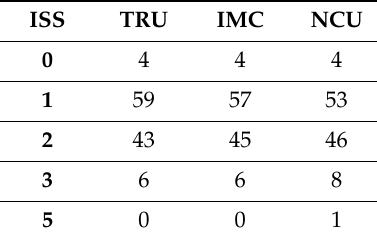
Table 5. Frequencies of all observed ISS values in the units.